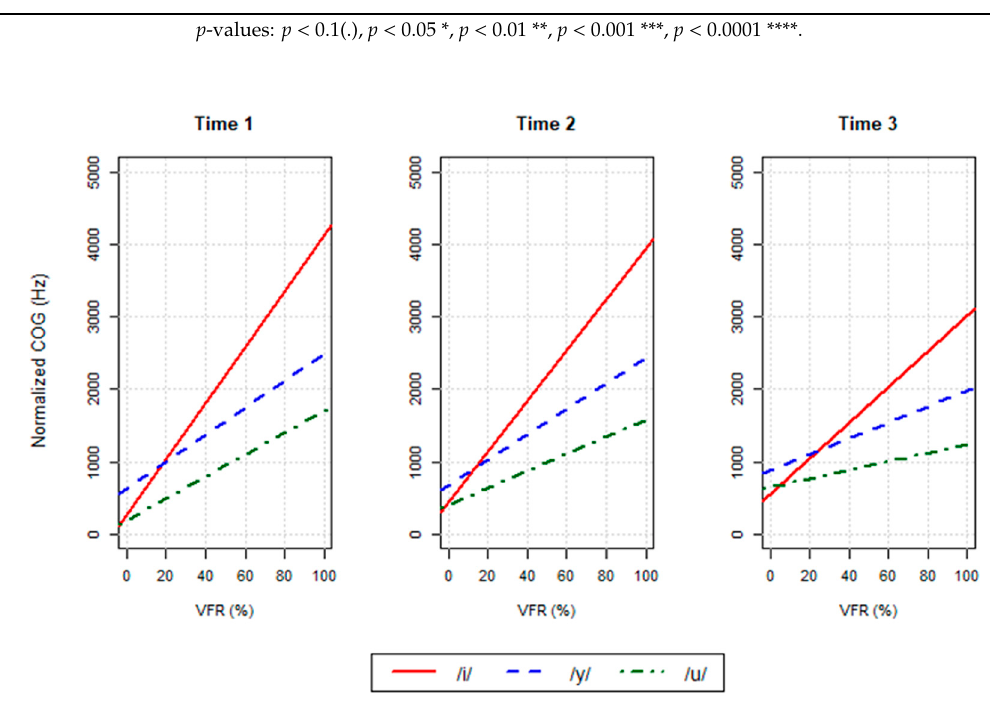
Figure 4. COG by speaker group and FVR at all timepoints. Timepoint 2 (50%). A second mixed-effects linear regression model was fit for COG at Timepoint 2, with similar results, as pictured in Table 3. As at Timepoint 1, there was an interaction effect between vowel and FVR , shown in Figure 3, such that higher PFFE-to-vowel ratios corresponded to higher COG values, with more pronounced differences between COG values at 0% and 100% for /i/ than /y/ or /u/. There was also a similar interaction between speaker group and FVR , such that L2 speakers exhibited higher COG values than L1 speakers at low FVRs (see Figure 4). No significant interaction was observed between vowel and speaker group . However, there was a main effect for speaker group , such that L2 speakers produced PFFE 619.32 Hz higher than L1 speakers. There was also a trending main effect for vowel , such that after all interactions were taken into